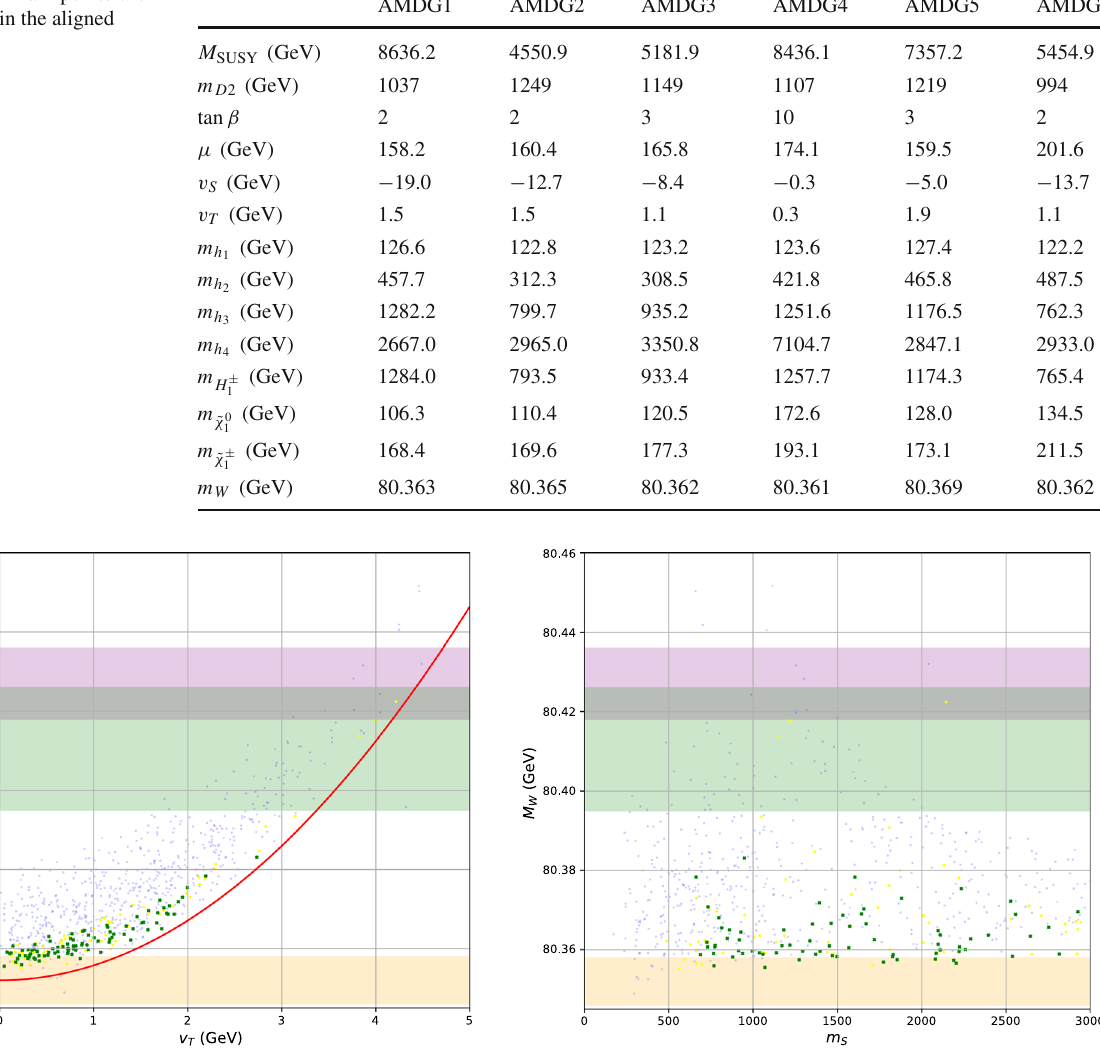
Fig. 3 Points in the aligned MDGSSM. Left: M W against triplet expectation value. Right: M W against singlet-like scalar mass. Colour coding as for previous